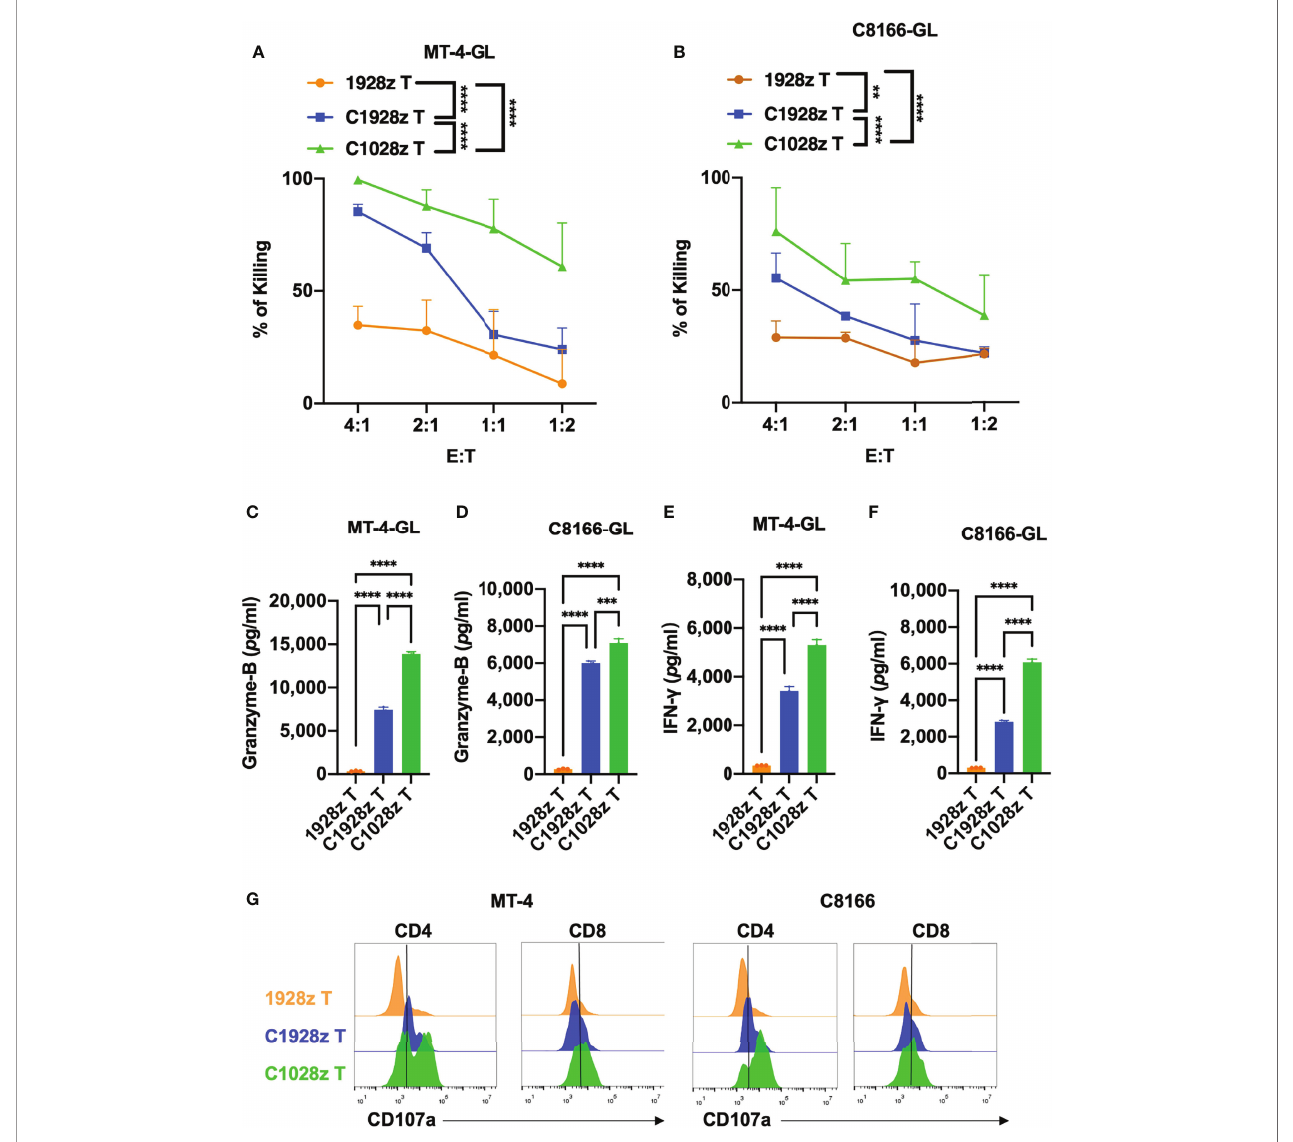
FIGURE 3 | Anti-CCR8 CAR T cells exhibited antitumor ef fi cacy against ATLL cells in vitro . (A, B) The percentages of MT-4 (A) and C8166 cells (B) whose lysis was induced by 1928z, C1928z and C1028z T cells; (B – F) 1928z, C1928z and C1028z T cells were incubated with MT-4 or C8166 cells at a 4:1 effector (E) target (T) ratio in 96-well round-bottom plates for 24 hours at 37°C. Supernatants were then harvested and analyzed with a multiplex immunoassay to determine the concentrations of the indicated cytokines. The concentrations of Granzyme-B (C, D) and IFN- g (E, F) were measured by ELISA; (G) The level of CD107a, as detected by fl ow cytometry, in 1928z, C1928z and C1028z T cells after coculture with MT-4 or C8166 cells for 24 h; (A, B) Data are shown as the mean ± SEM values; two-way ANOVA with Tukey ’ s multiple comparisons test; **P ≤ 0.01, ****P ≤ 0.0001; (C – F) Data are shown as the mean ± SEM values; one-way ANOVA with Tukey ’ s multiple comparisons test; **P ≤ 0.01, ***P ≤